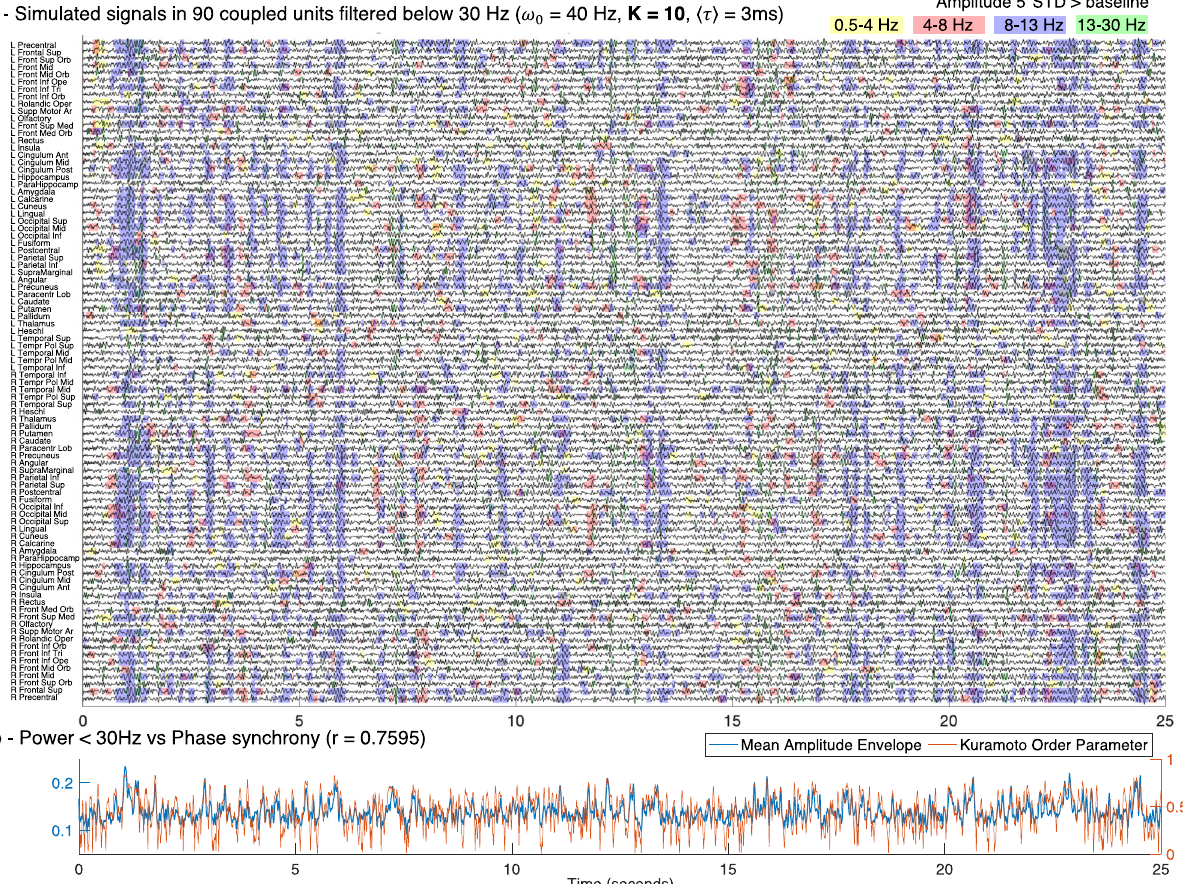
Fig. 4 Sub-gamma oscillations emerge from weakly stable cluster synchronization. a An example of the simulated signals in all 90 units plotted over 25 s, each representing a brain area from a brain parcellation template, fi ltered below 30 Hz to highlight the sub-gamma oscillatory activity typically detected with magnetoencephalography (MEG). Shades indicate the time points of increased power in the delta (yellow), theta (red), alpha (blue) and beta (green) frequency bands. For each frequency band, the threshold was de fi ned as fi ve standard deviations (STD) of the amplitude — in the same frequency bands — when no delays were considered. For the simulations, the resonant frequency, ω 0 , of all units was set to 40 Hz, the conduction speed was tuned such that the average delay between units, 〈 τ 〉 , was 3 milliseconds (ms) and the global coupling strength was set to K = 10. b The mean amplitude envelope (blue) of the fi ltered signals shown in ( a ) correlates with a Pearson ’ s correlation coef fi cient r = 0.7595 with the phase synchronization evaluated by the Kuramoto Order Parameter (orange, right y